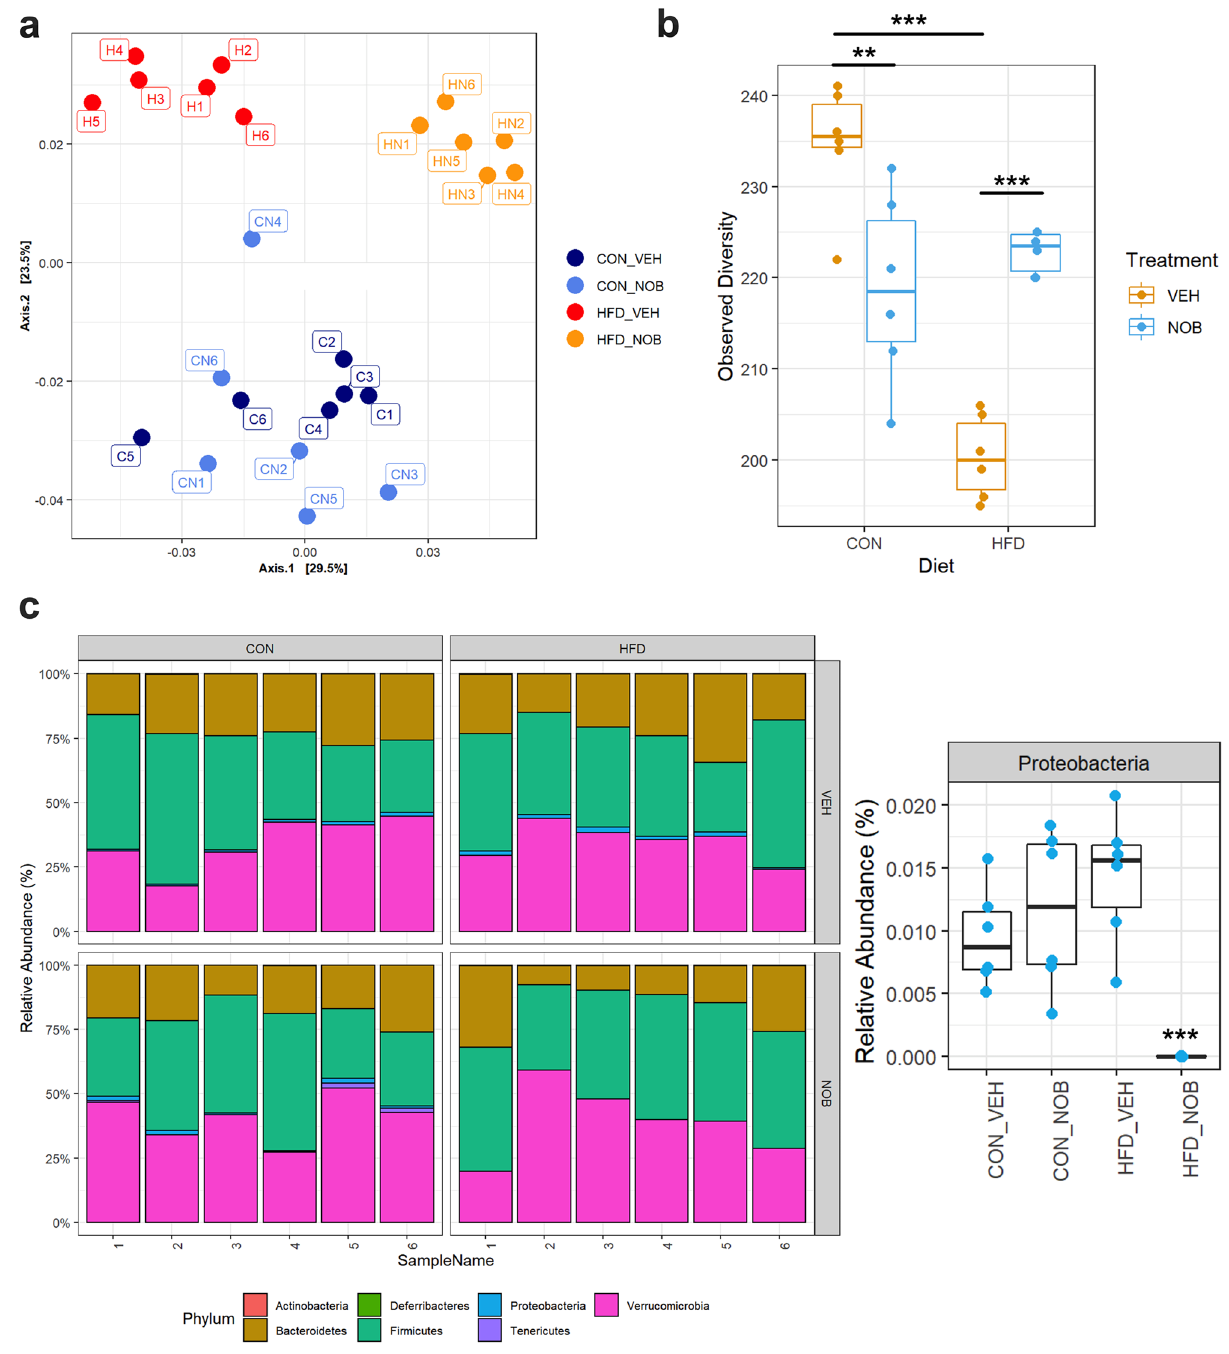
Figure 6. Nobiletin improves the gut microbiome in HFD-fed mice. ( a ) Principal component analysis, ( b ) species diversity, and ( c ) relative abundance of phyla, including a plot for Proteobacteria, of the colonic microbiome at ZT14 from control (CON) and high-fat diet (HFD)-fed mice without (vehicle; VEH) or with nobiletin (NOB) supplementation. n = 6, with each dot and each bar showing the data for a single animal; **p < 0.01 ***p <